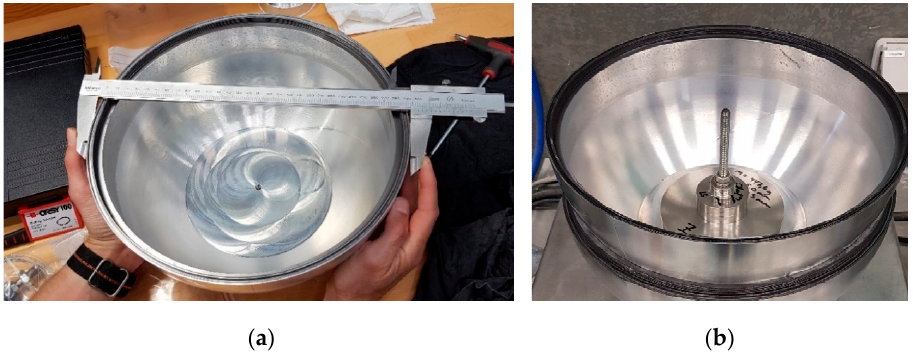
Figure 5. Unballasted hemisphere shell with a diameter of 300 mm ( a ). Ballasted hemisphere shell with rubber gasket ( b ).